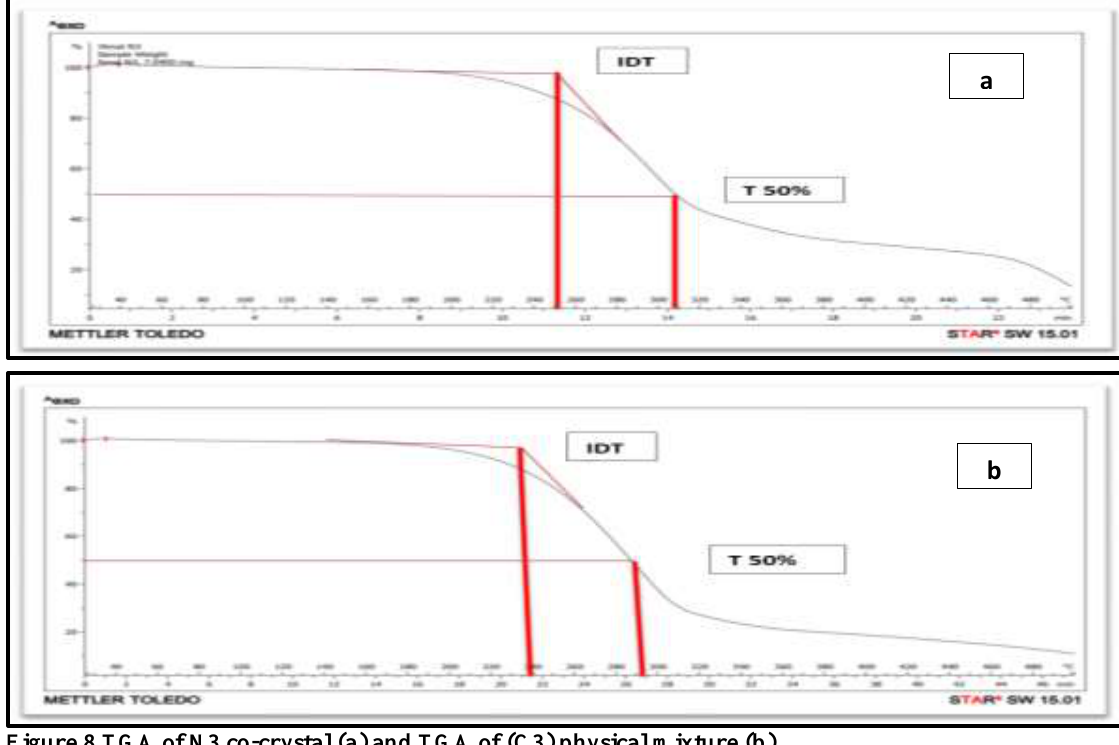
Figure 8.TGA of N3 co-crystal (a) and TGA of (C3) physical mixture (b).